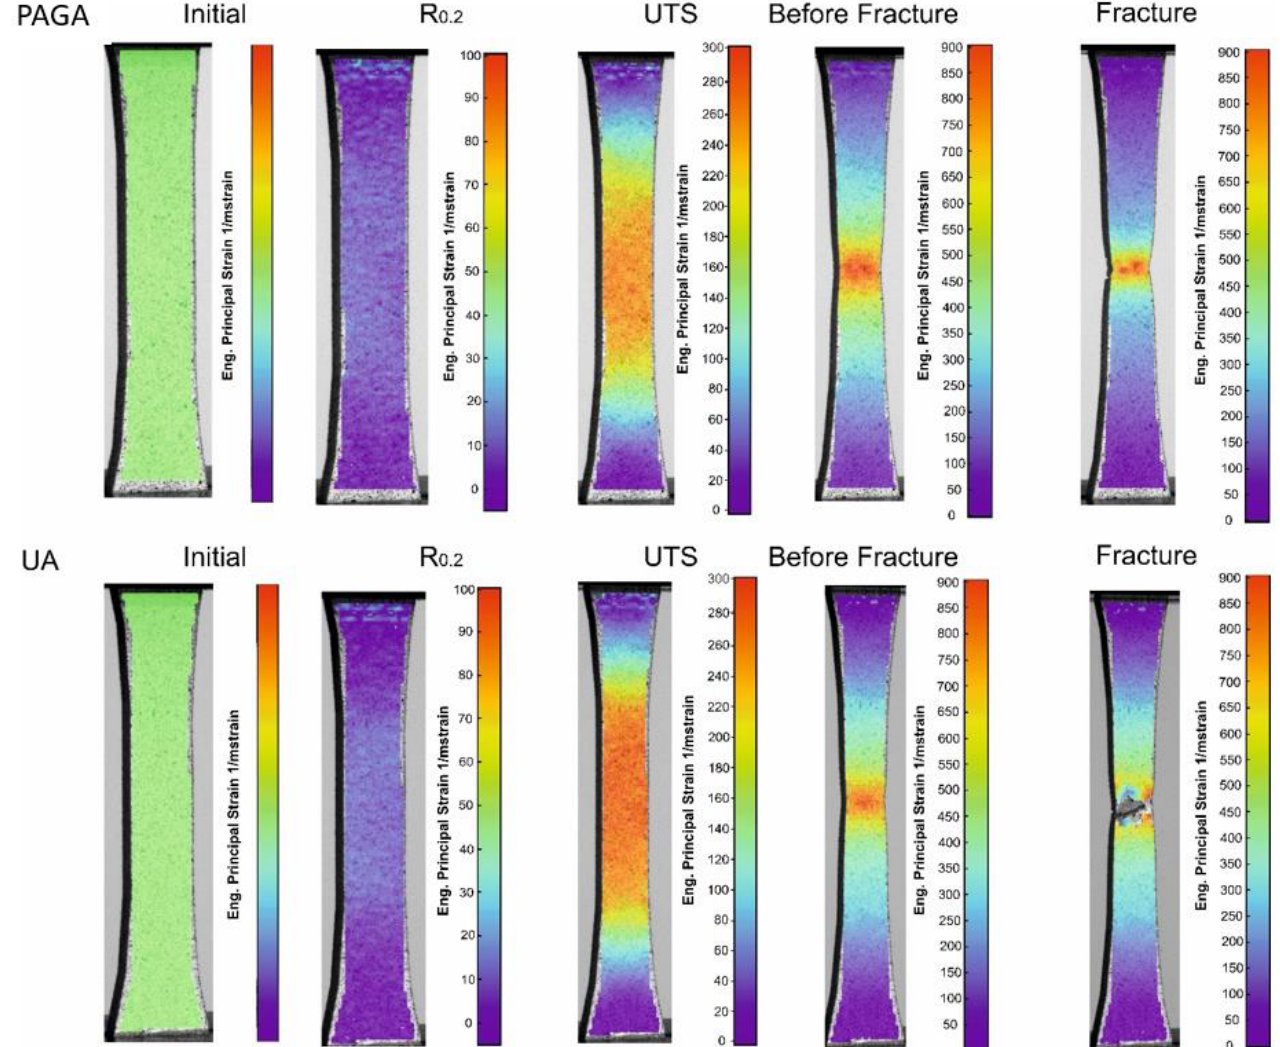
Figure 11. DIC results of samples manufactured using both powders during tensile testing. DIC analysis revealed different behaviors for each material during strain. Samples made of PAGA powder deformed less equally in a smaller area than samples made of UA until reaching the UTS, where there were visibly increased strain areas in PAGA samples. In both cases, necking is visible, proving the high plasticity of test parts made of PAGA and UA